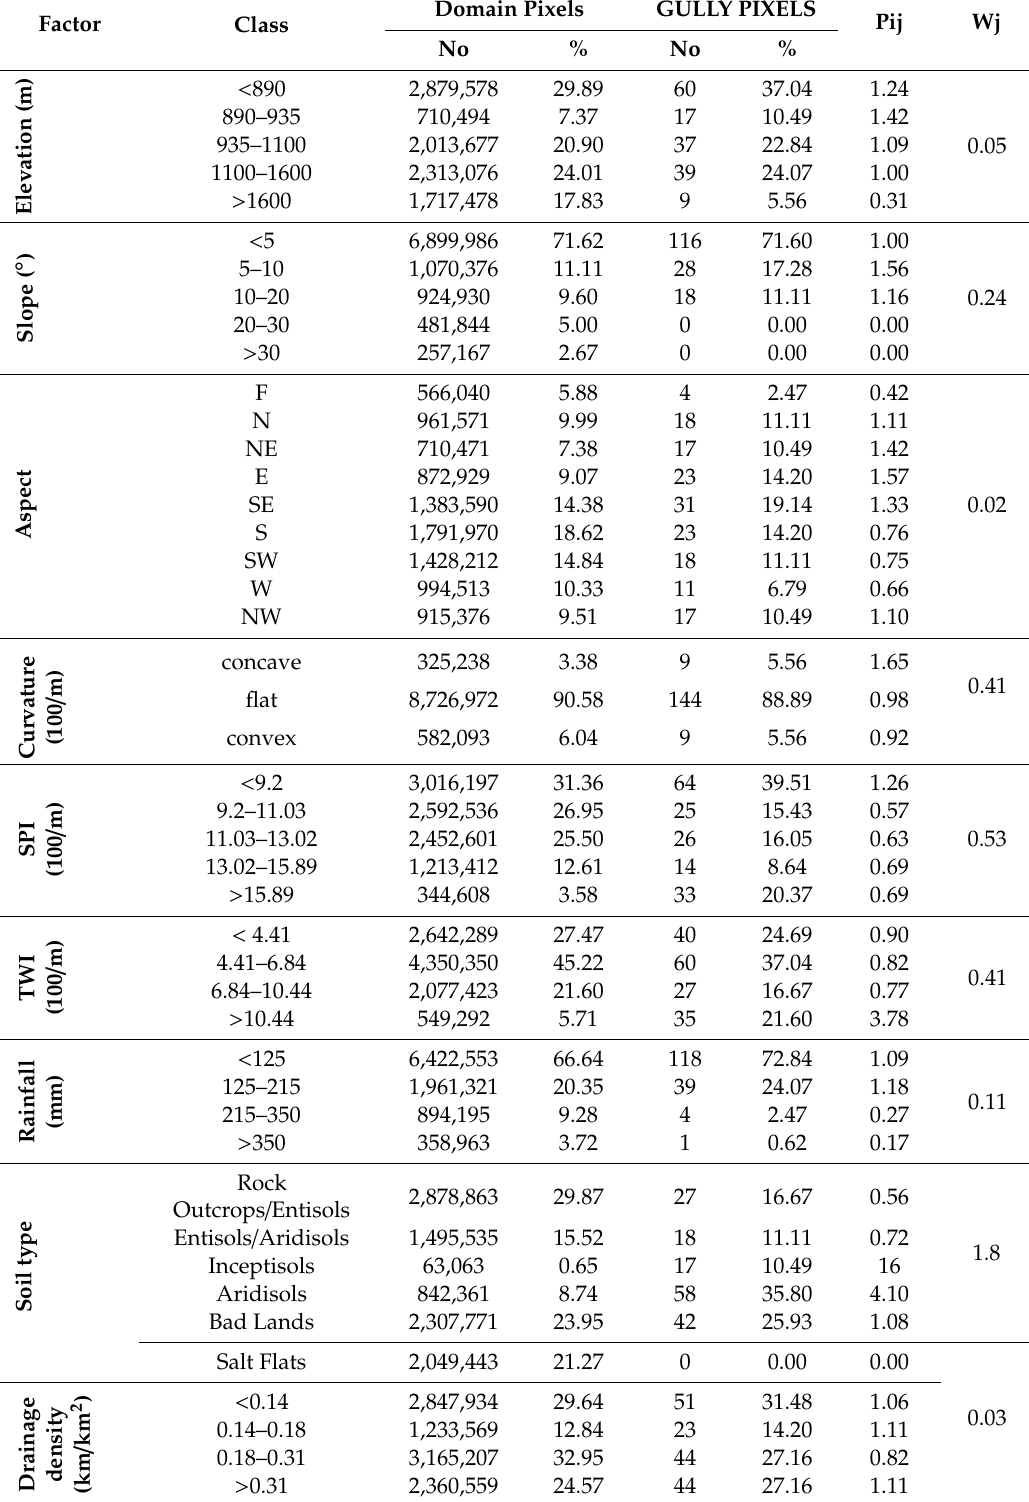
Table 3. Relationship between gully erosion and gully conditioning factors using the index of entropy.